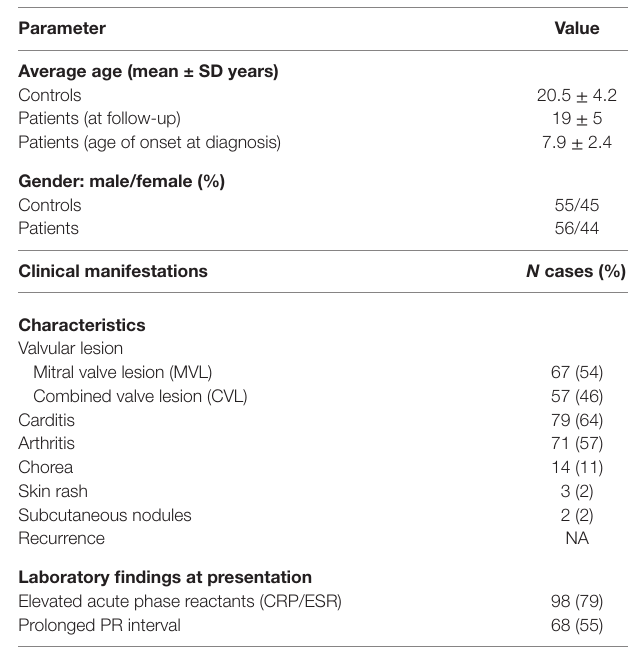
TaBle 1 | Demographic characteristics and clinical details of the patients ( n = 124) and controls ( n =